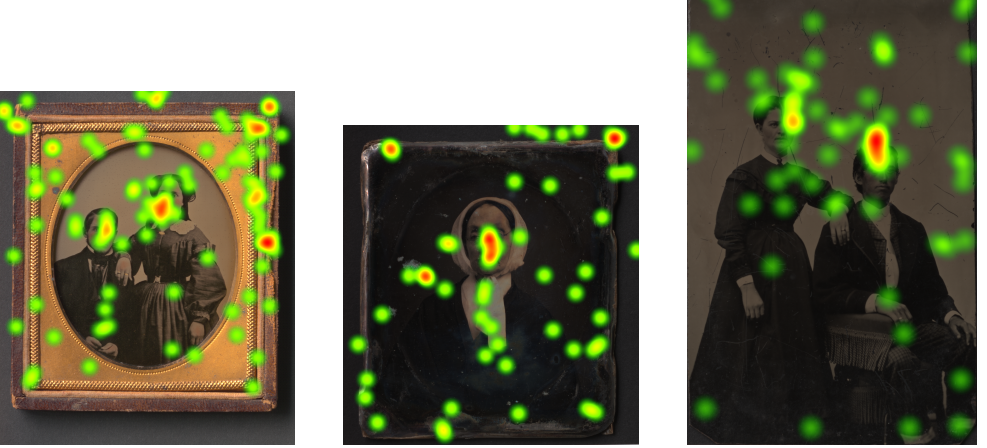
Figure 2. These three heatmaps show looking behavior of two restoration expert participants to the Ambrotype, Daguerreotype and Tintype scanned with the LLa scanning